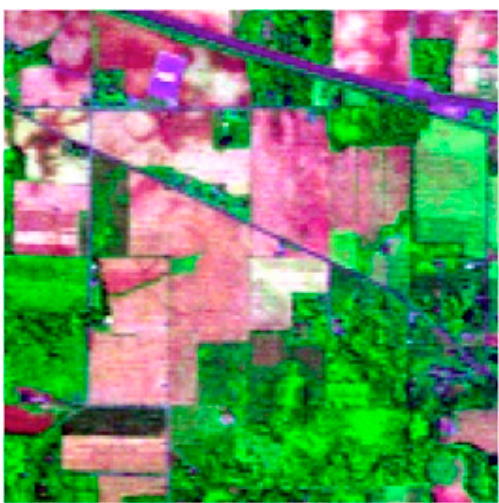
Figure 6. The false color composite image (15, 100 and 180 bands) of the Indian Pines hyperspectral dataset consisted of a 2.9 × 2.9 km 2 (145 × 145 pixels) land of Northwest Tippecanoe County in the Indian Pine region.